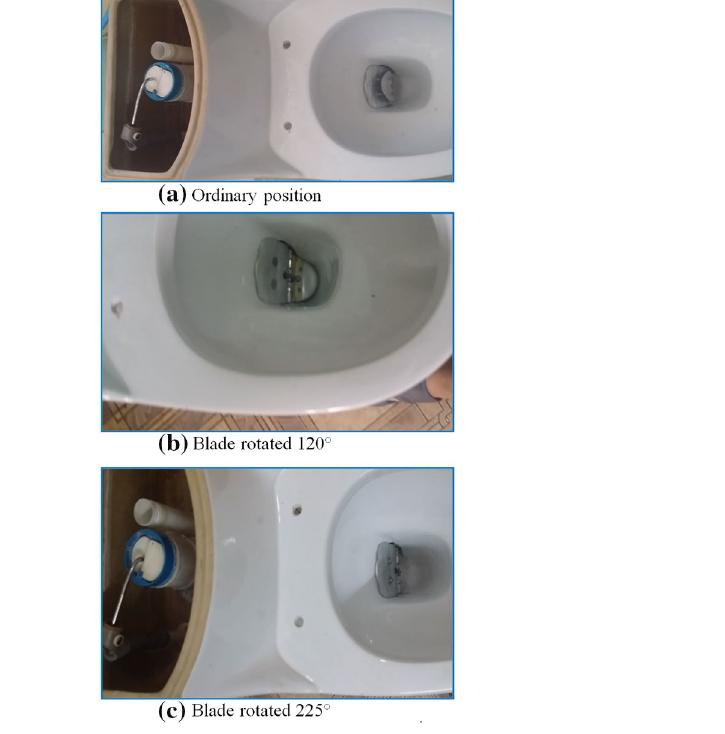
Fig. 5 Steps of moving down solid rotatable blade